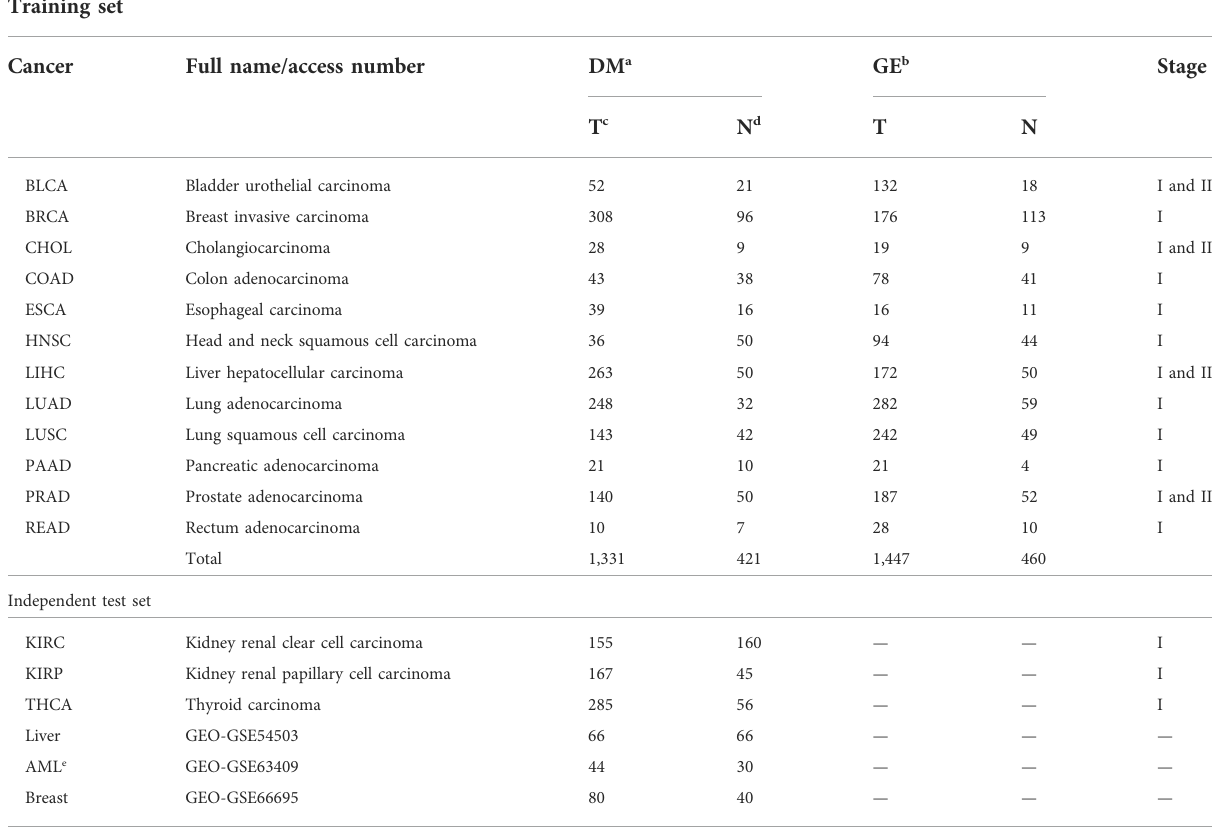
a DM, DNA methylation. b GE, gene expression. c T, tumor samples. d N, non-malignant samples. e AML, acute myelogenous